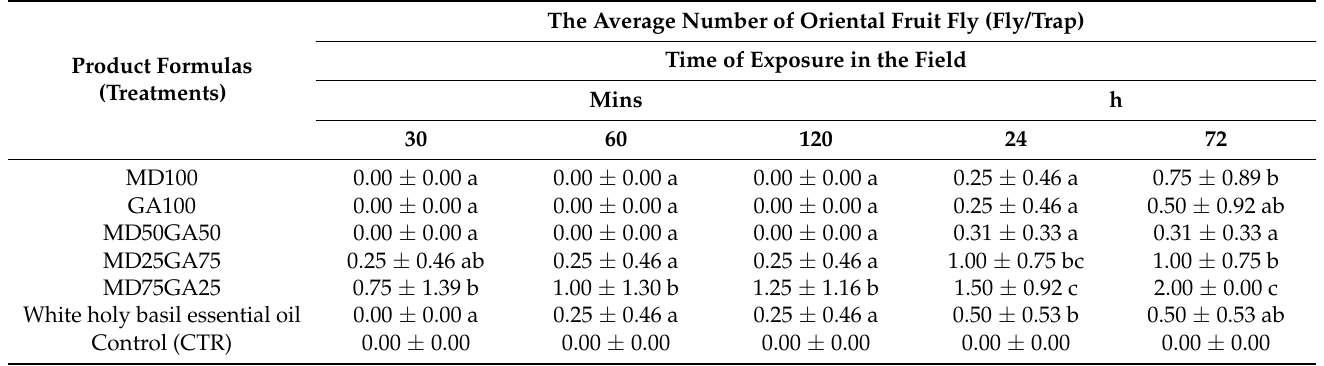
Table 7. Number of flies per trap with different lures at the period of 72 h.